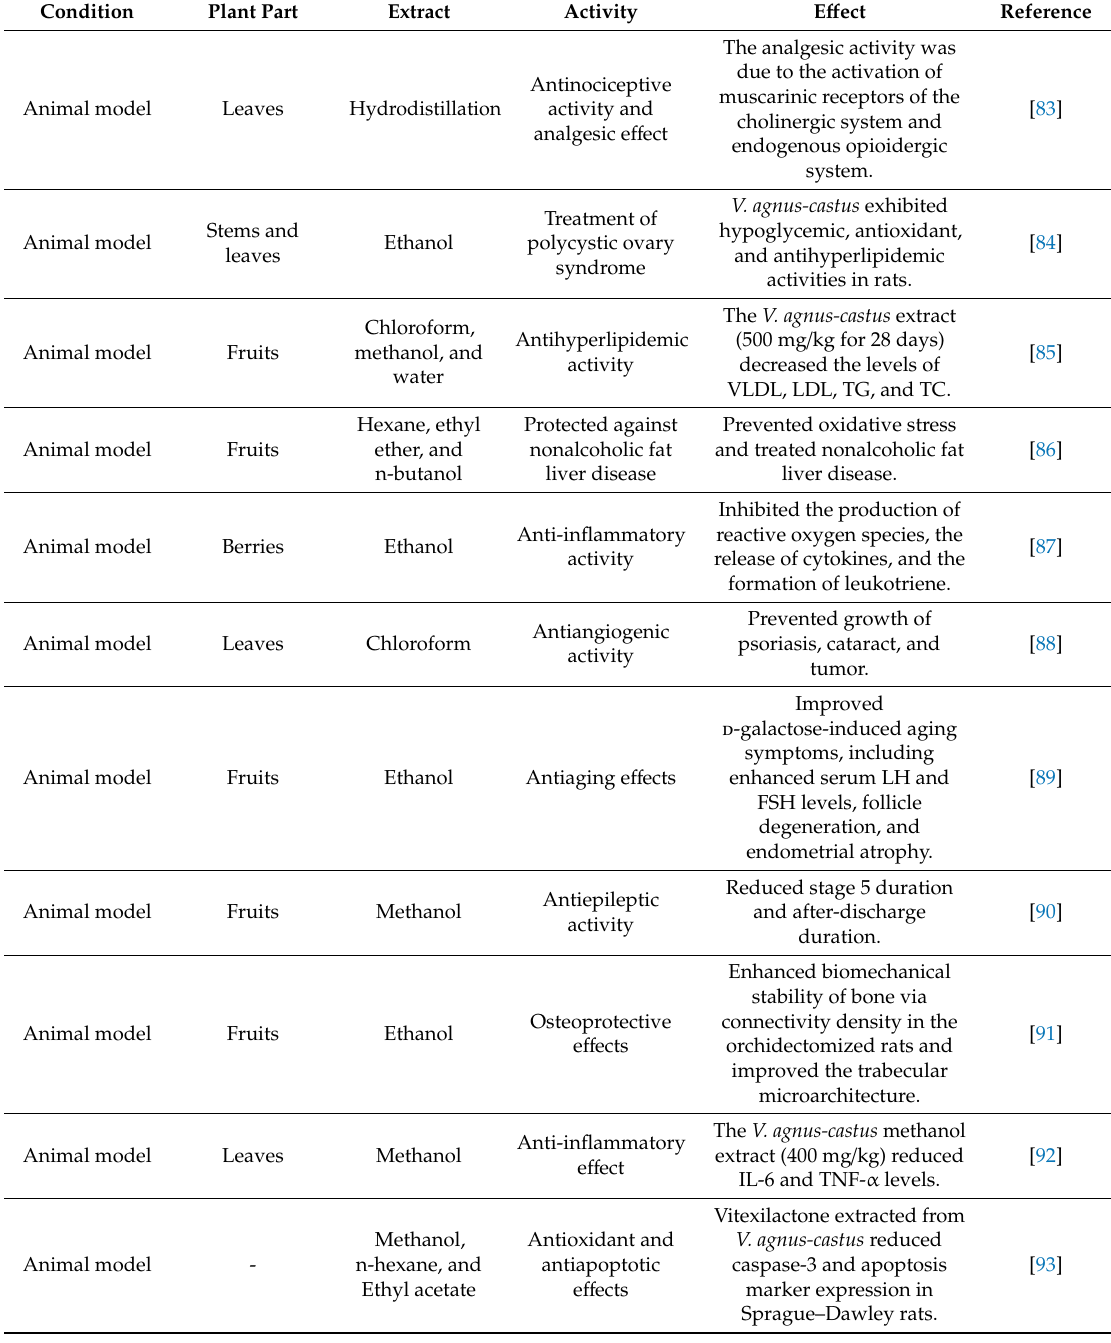
Table 2. Animal model reported activities for V. agnus-castus